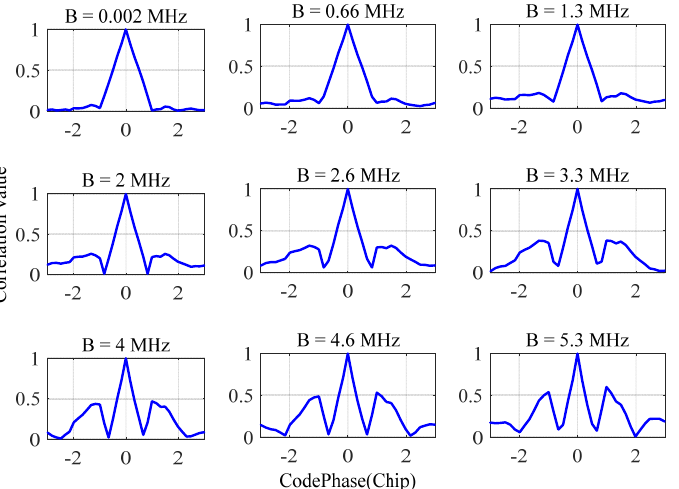
Figure 6. Correlation peak distortion caused by narrowband interference suppression.